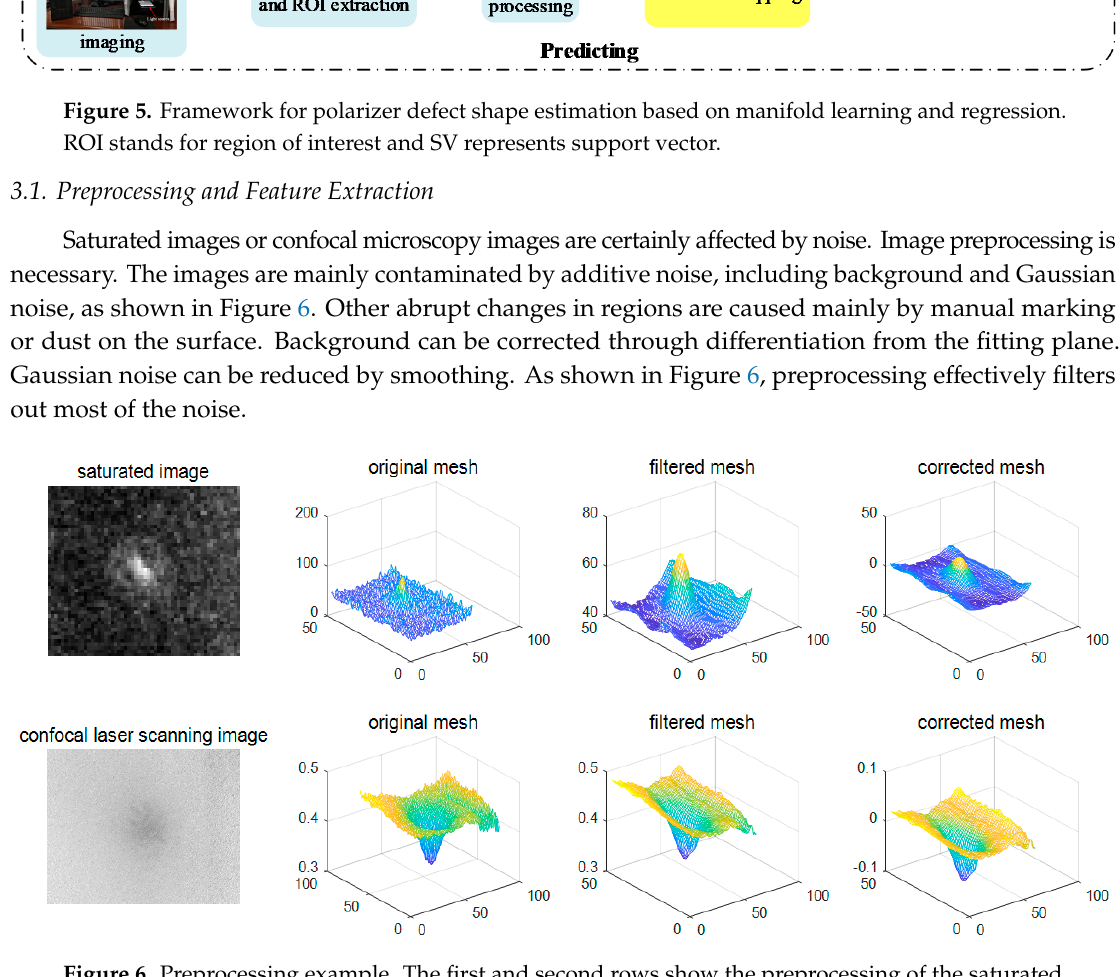
Figure 5. Framework for polarizer defect shape estimation based on manifold learning and regression. ROI stands for region of interest and SV represents support vector.